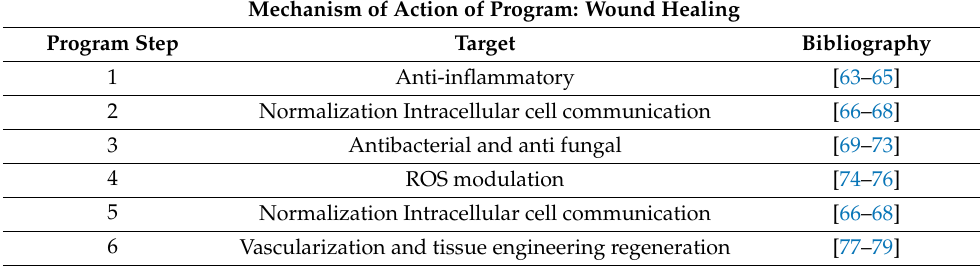
Table 3. Steps and bibliography.